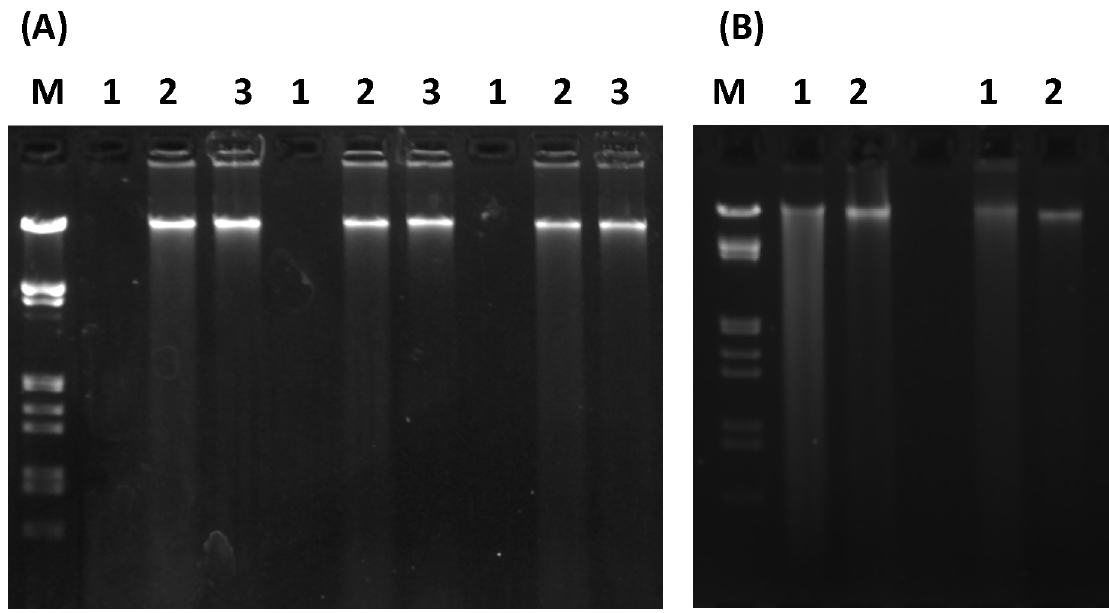
Figure 2. Phosphate test. ( A ) PB pellet wash test. Lysis was performed for 3 replicate extractions using (4 M guanidine thiocyanate; 100 mM MOPS (pH 7.0) 25 mM EDTA; 1% sarkosyl). Lanes 1, standard extraction process result from 200 mg iron cemented clay. Lanes 2, first of two clay pellet washes using 250 m l PB (pH 7.0). Lanes 3, second clay pellet wash using 250 m l PB. Lane M; Marker III (Roche). B) Test with PB in the lysis reagent. ( A ) Lane 1; extraction result from lysis reagent containing 1 M PB and 6 M guanidine HCl followed by sample dilution in a concentrated salt based extraction buffer. ( B ) Lanes; extraction result from lysis reagent containing 1 M PB and 6 M guanidine HCl followed by sample dilution in 1. 4 ml urea based extraction buffer. Lanes 2; result from 250 m l clay pellet PB wash (Both A and B). Lanes M; Marker III (Roche). Samples were electrophoresed for